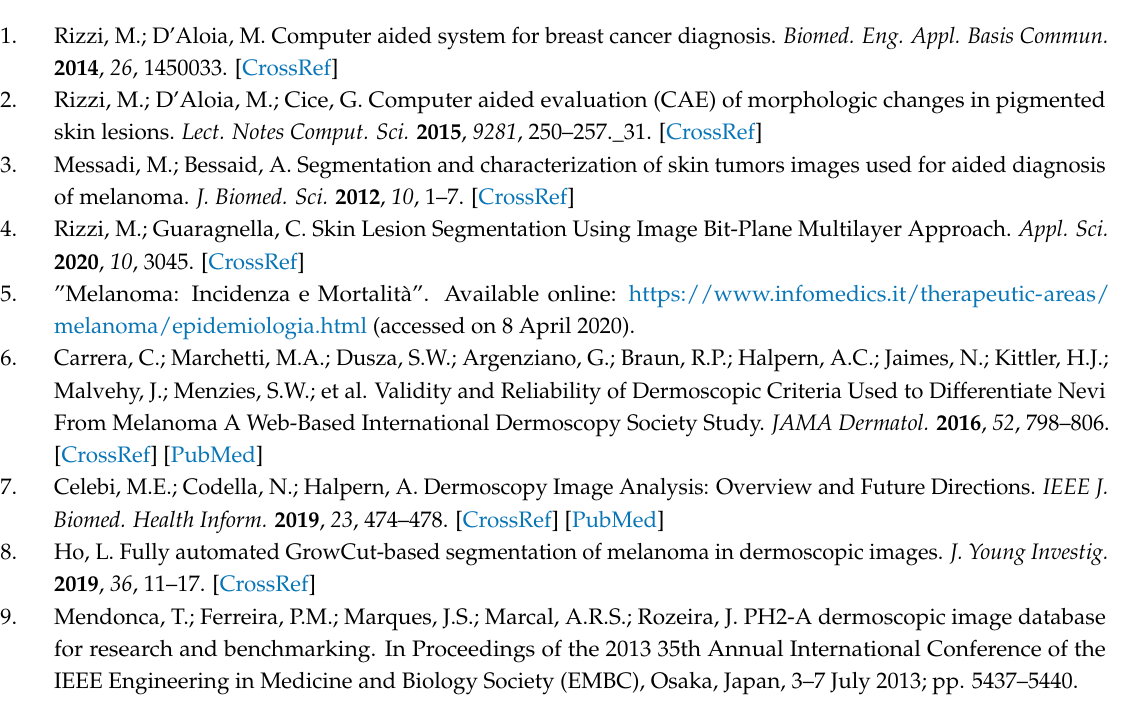
Figure 4. Some of the experimental results obtained by the procedure are reported. In particular, original images of melanoma, which are shown with over-imposed contours obtained in the segmentation phase, are compared with the segmented areas obtained as outputs of the proposed method. In the performance evaluation of the conceived procedure, all the data-set images have been tested, contrary to what some other papers indicated in literature have performed [4]. The reason of this rejection is based on the image characteristics. In fact, several images of the PH2 database are heavily affected by poor illumination and presence of hair, some others contain multiple lesions and others are connected to the boundary edge of the provided image. Therefore, the method achieved the above indicated results taking also in consideration these challenging dermoscopic images. Independently of the performance achieved by the computer method, it is to emphasize that the effect of border detection imprecision on a CADx system can be only assessed when the segmentation procedure is integrated in a diagnostic